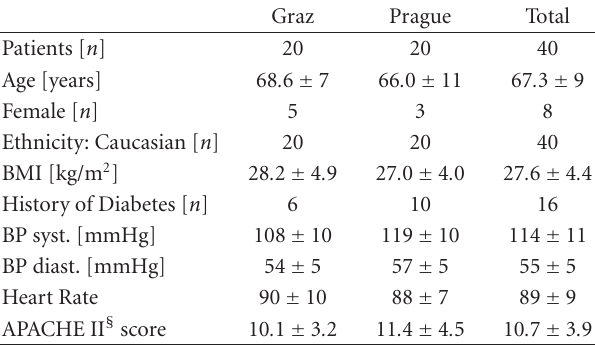
Table 1: Baseline